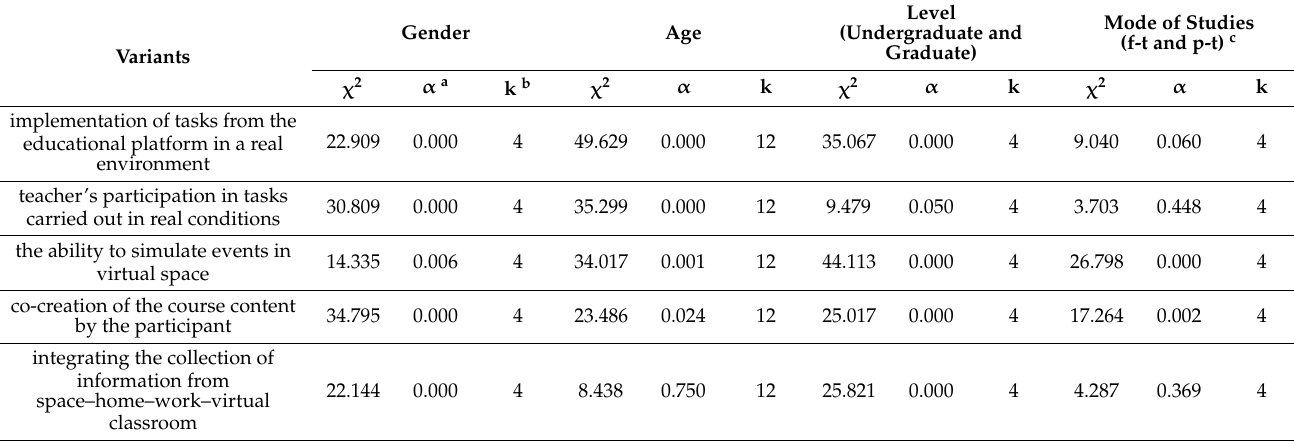
Table 2. Smart learning representation by gender, age, level, and mode of study–test of independence χ 2 .